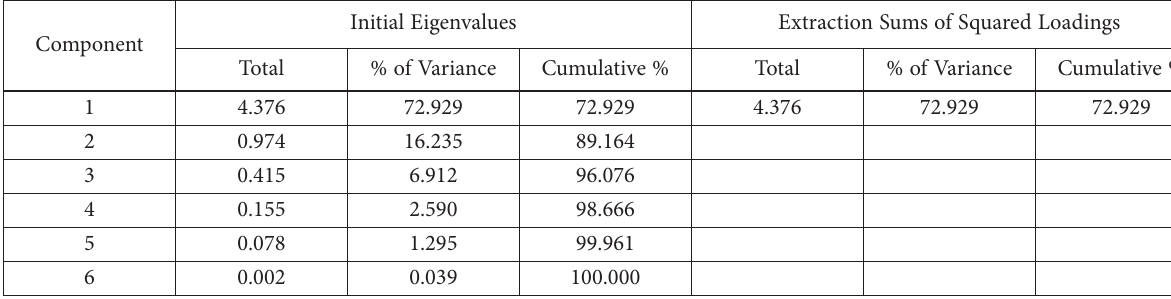
Table 8a. Total explained variance of the heavy metal